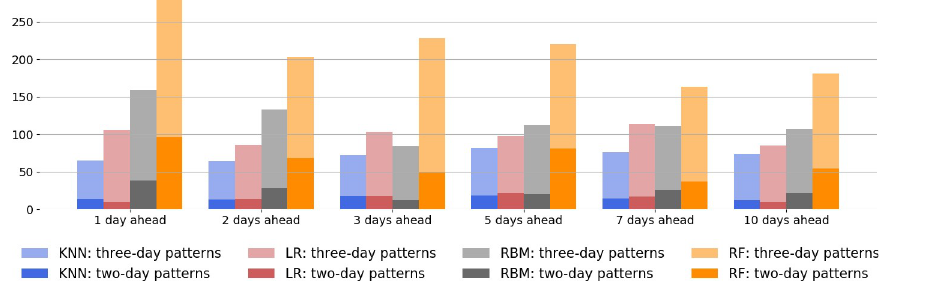
Fig 6. The number of the four machine learning methods supporting highest prediction